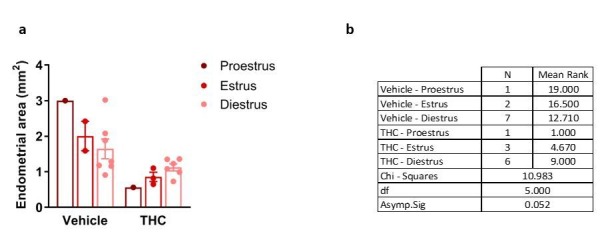
Effects of THC and stage of the estrous cycle on cyst endometrial area.(a) Cyst endometrial area in the different group treatments and estrous cycle stages. (b) Shapiro-Wilk test revealed that data on endometrial area did not follow a normal distribution. Subsequent Kruskal-Wallis test showed no significant difference among these groups. Error bars are mean ± SEM. Endo, endometriosis.